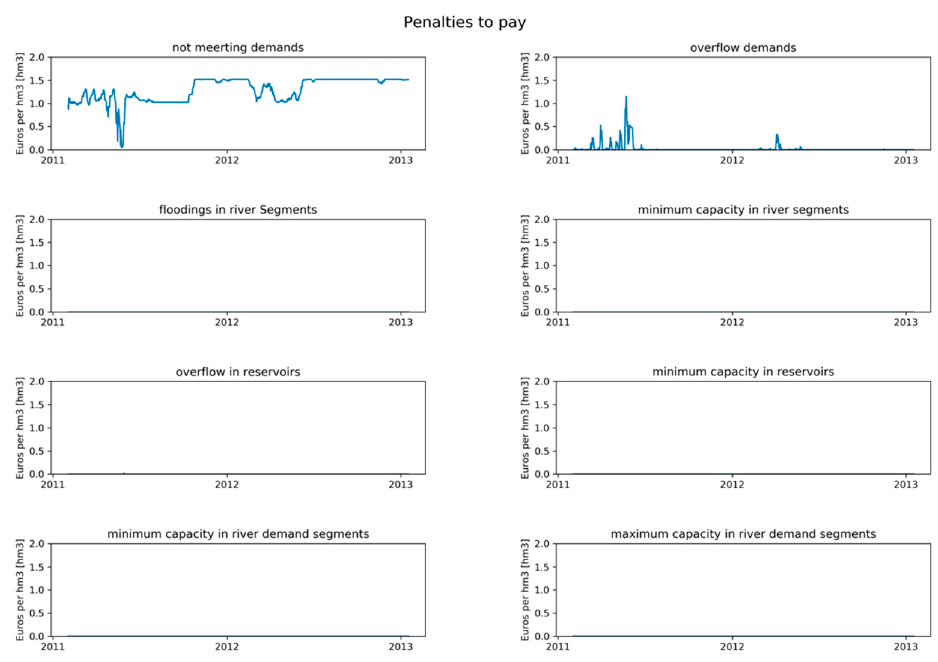
Figure 14. Daily penalties during the 2-year period. Table 6. Deviation between the volume of water targeted and achieved after optimization (m 3 ) and associated penalties (€).